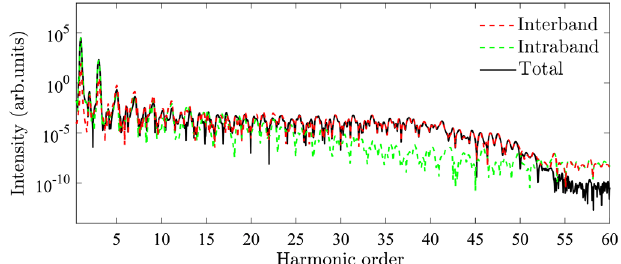
FIG. 11. High-harmonic spectra from the NP point in the KM model. The intraband and interband harmonics dominate the lower- and higher-frequency regions, respectively.